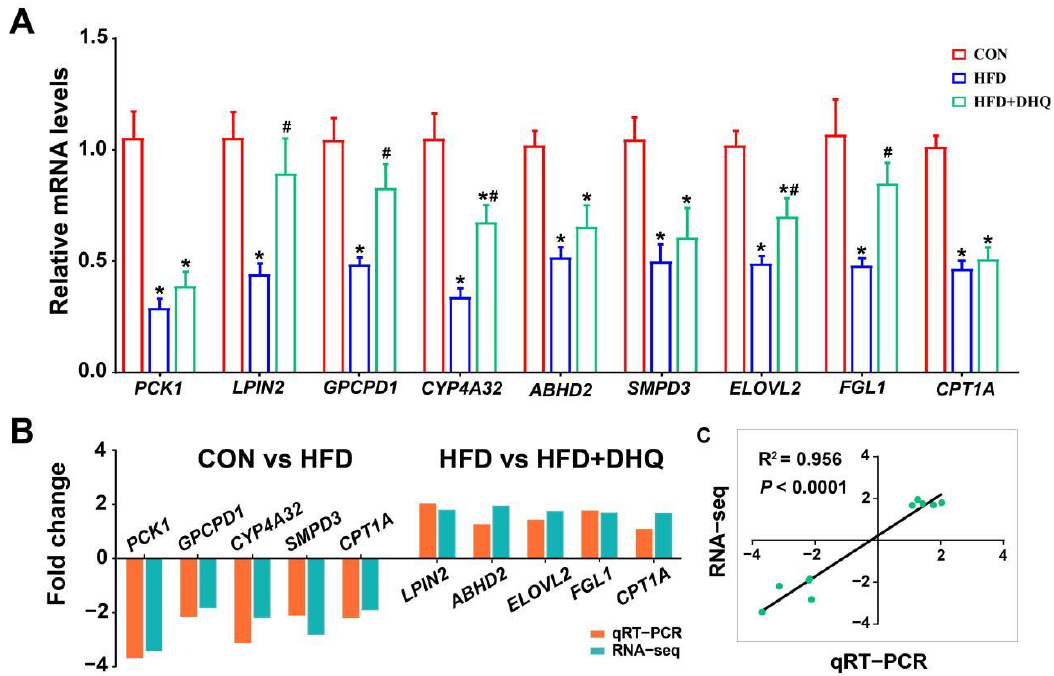
Figure 7. qRT-PCR validation of 9 DEGs selected randomly. ( A ) Relative mRNA levels of PCK1 , LPIN2 , GPCPD1 , CYP4A32 , ABHD2 , SMPD3 , ELOVL2 , FGL1 , and CPT1A ; ( B ) fold change of up-regulation or down-regulation in RNA-seq and qRT-PCR assays; and ( C ) correlation analysis. Data were expressed as the mean ± SEM. * p < 0.05 vs. CON group, # p < 0.05 vs. HFD group.